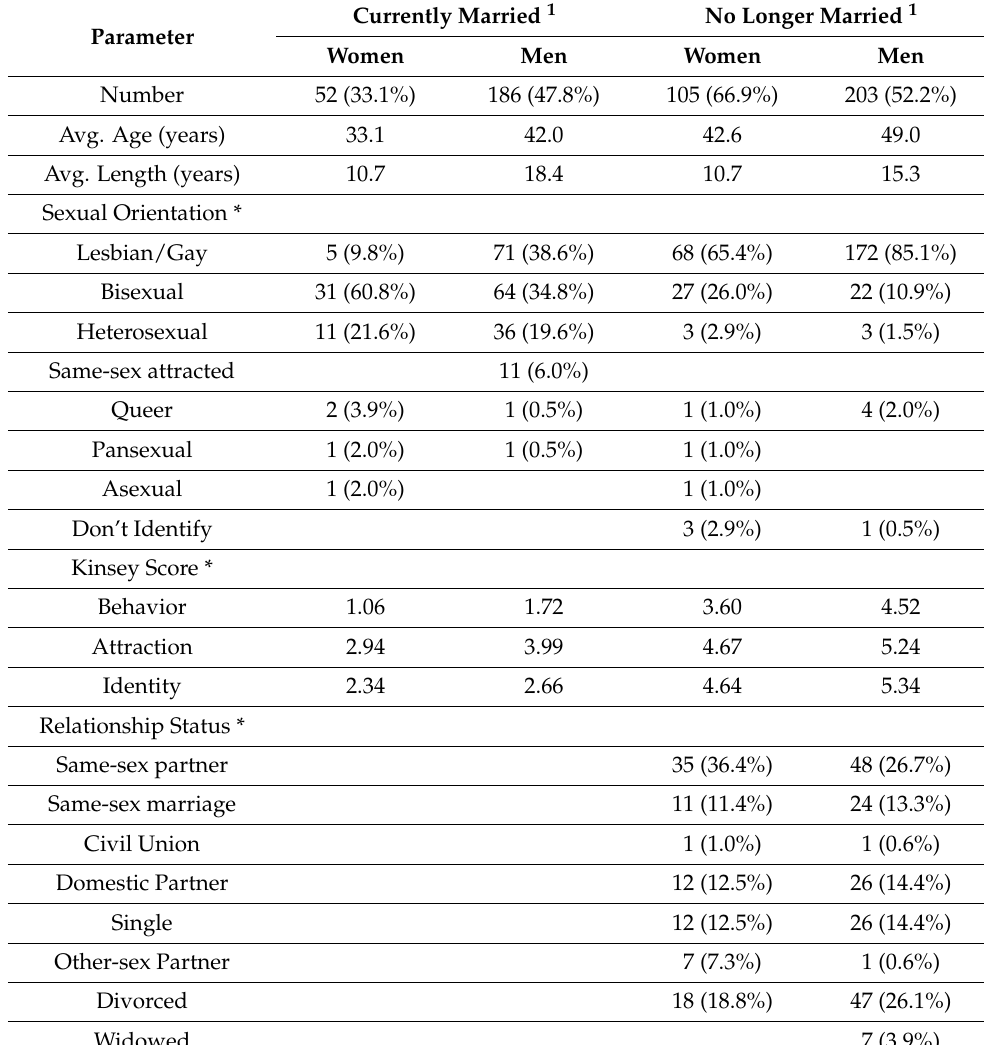
Table 5. Mixed-Orientation Marriage as a Function of Sexual Orientation.